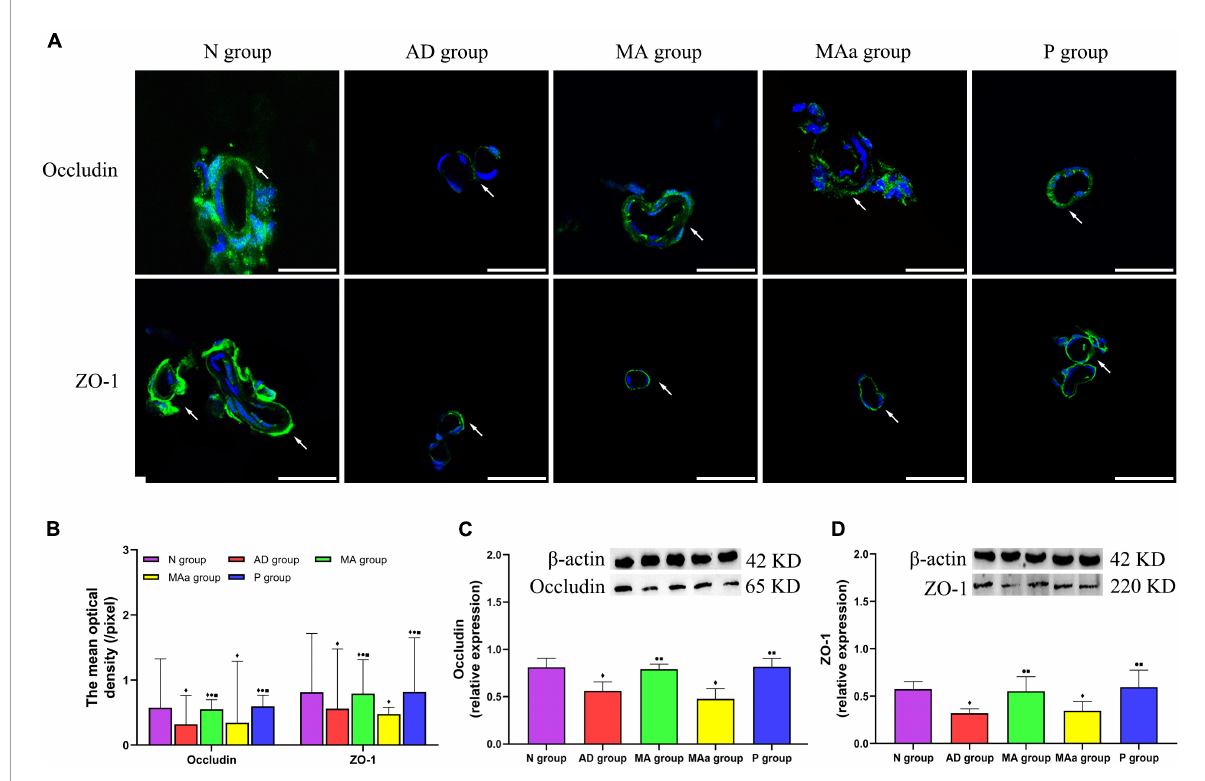
FIGURE4 Results of the BBB-associated proteins in each group ( n = 6, mean ± SD). (A) Representative images of IF staining of Occludin and ZO-1. Occludin and ZO-1 are labeled with green fluorescence. Scale bar is 50 µ m. (B) Comparison of the mean optical density of Occludin and ZO-1 in each group . (C,D) Comparison of the relative expression of Occludin and ZO-1 in each group. Compared to the N group, (cid:7) p < 0.01 or p < 0.05. Compared to the AD group, • p < 0.01 or p < 0.05. Compared to the MAa group, (cid:4) p < 0.01 or p <